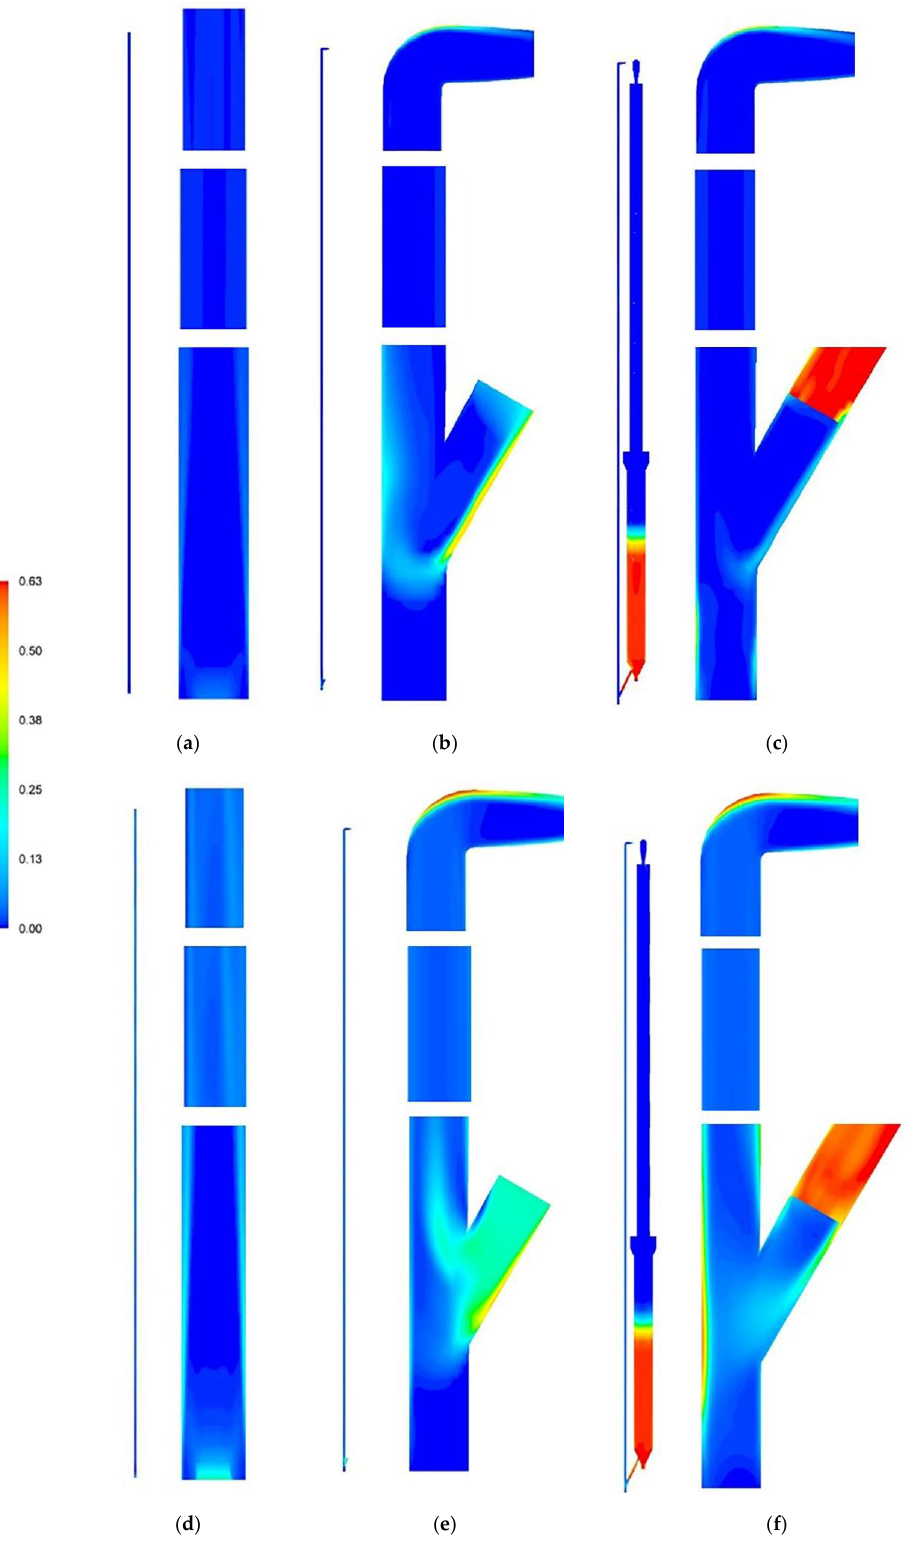
Figure9. ComparisonofsolidsholdupdistributioninCFBamongdi ff erentmethods. ( a )Riser-simplified simulation in U g = 7 m s − 1 , G s = 50 kg m − 2 s − 1 ; ( b ) riser-only simulation in U g = 7 m s − 1 , G s = 50 kg m − 2 s − 1 ; ( c ) full-loop simulation in U g = 7 m s − 1 , G s = 50 kg m − 2 s − 1 ; ( d ) riser-simplified simulation in U g = 7 m s − 1 , G s = 300 kg m − 2 s − 1 ; ( e ) riser-only simulation in U g = 7 m s − 1 , G s = 300 kg m − 2 s − 1 ; ( f ) full-loop simulation in U g = 7 m s − 1 , G s = 300 kg m − 2 s − 1